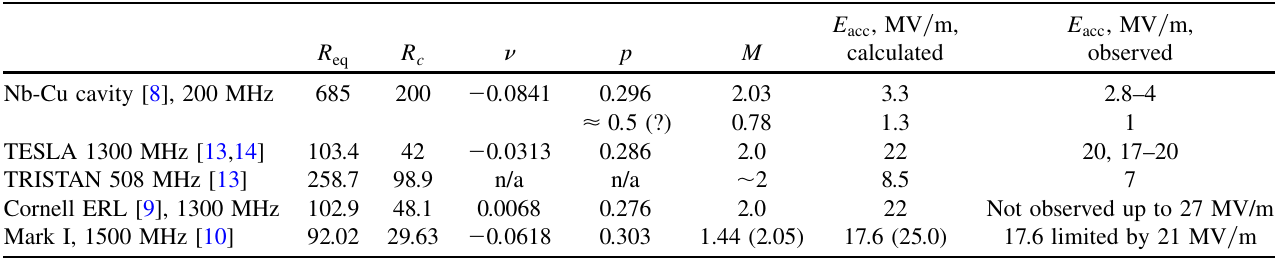
TABLE I. Parameters of some cavities and fields of calculated and observed